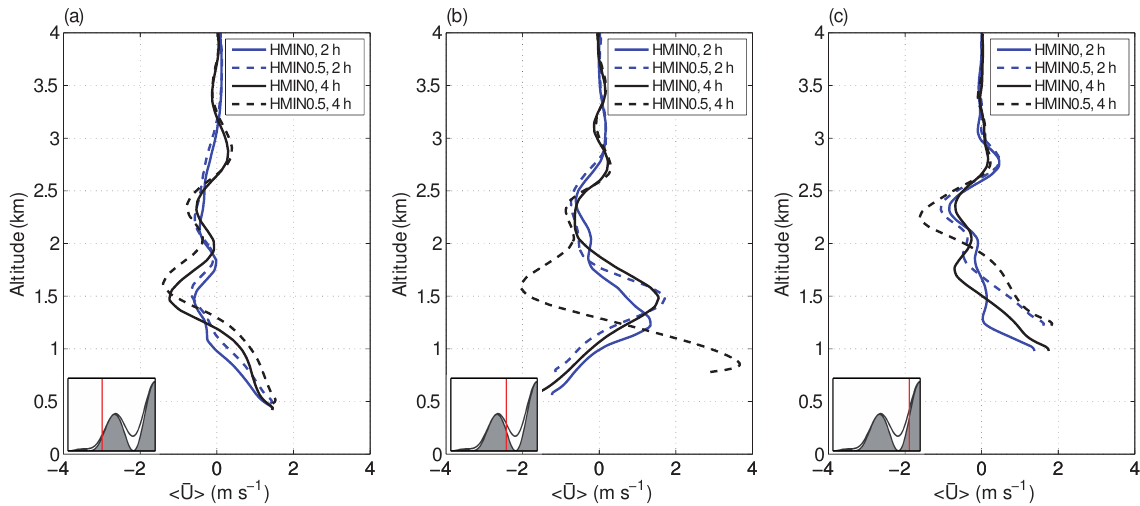
Figure 4. Vertical profiles of temporally and spatially averaged cross-mountain wind speed at (a) the middle of slope 1 ( x = − 18 . 2km), (b) the middle of slope 2 ( x = − 10 . 7km), and the middle of slope 3 ( x = − 3 . 7km) for the mountain shapes HMIN0 (solid lines) and HMIN0.5 (dashed lines). Black and blue lines are valid for 2 and 4h of simulation, respectively. Red lines in the inset show the location of the profiles. The averaging in time and space is done according to Eq. (5).